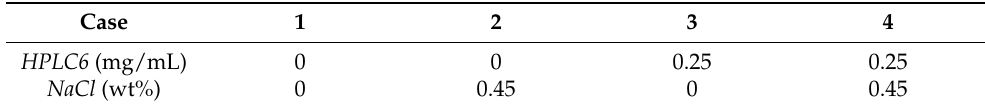
Table 1. Concentration condition of solutions.